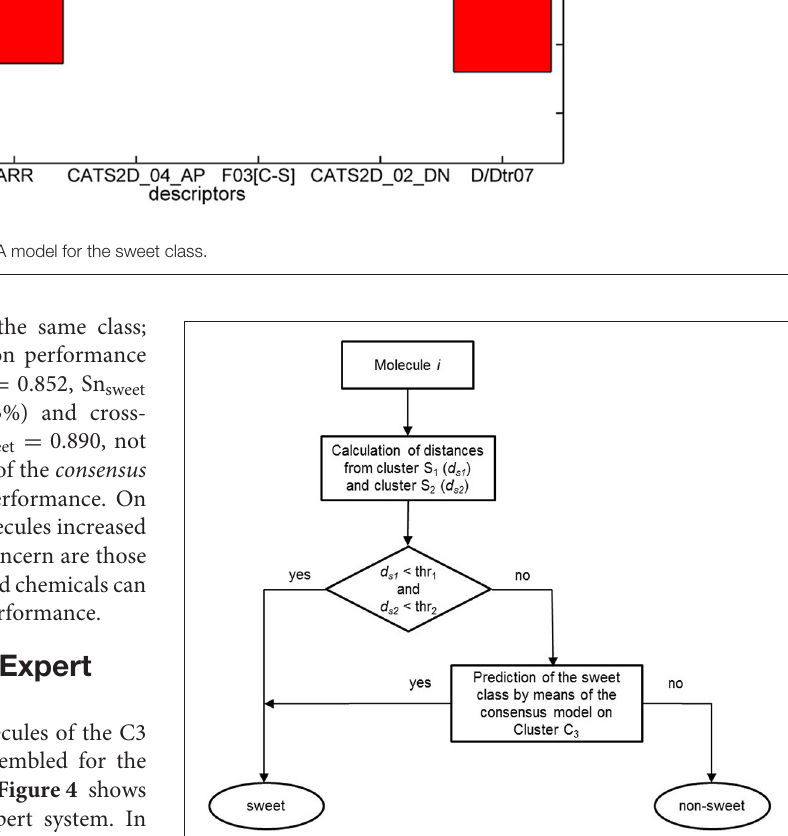
Performance in classification of the QSTR-based expert system is listed in Table 3 . Performance of the Monte Carlo validation based on 1,000 iterations (NER = 0.887, Sn sweet